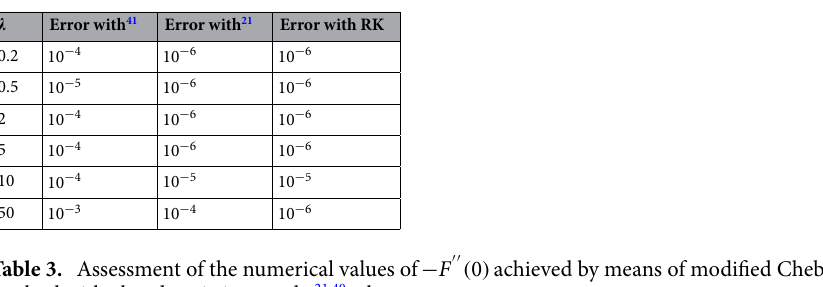
H 2 O, this is because of boundary layer thickness − 3 and after this no variation can be perceived for growing η ≥ ≤ 1.5, 3, 5 and 0 3 . Actually, owing to rotation effects oscil- η = ≥ ≤ 1.5 the rotation properties become dominant ≥